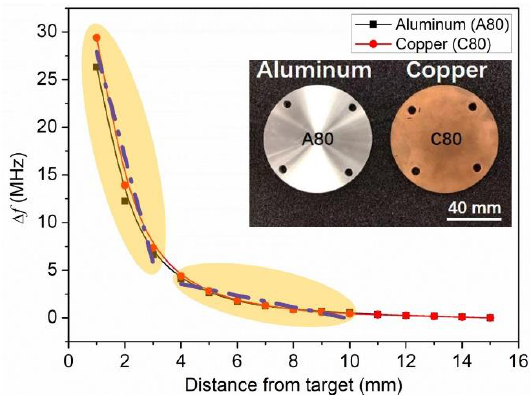
Figure 5. Frequency shift of the LC proximity sensor as a function of distance from the target for A80 and C80.